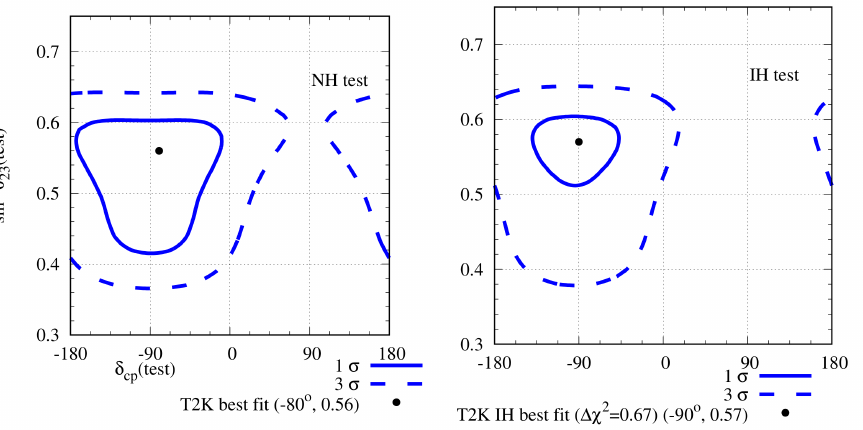
Figure 5. Expected allowed regions in the sin 2 θ 23 − δ CP plane from the appearance data from T2K, as given in Ref. [54,55], in both the ν e and ¯ ν e channels. In the left ( right ) panel, the hierarchy is assumed to be NH (IH). The best-fit point is at NH with a minimum χ 2 = 20.23 for 18 energy